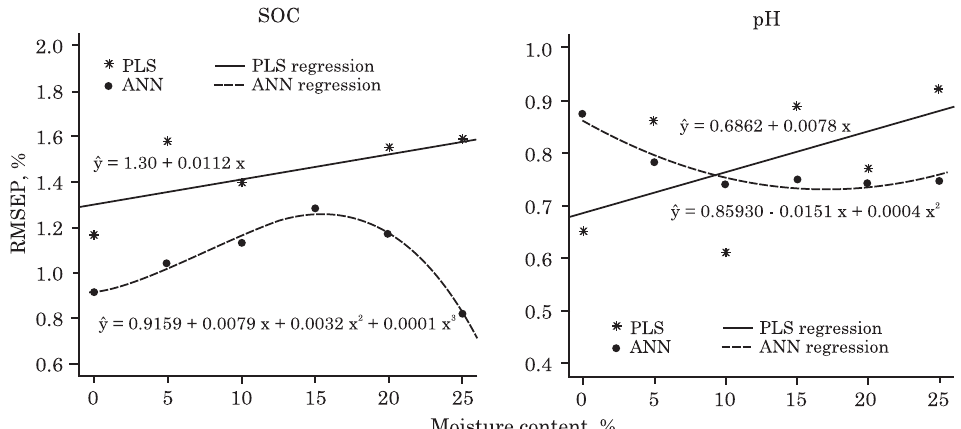
Figure 5. Root mean square error of prediction (RMSEP) for PLS and ANN models at different moisture content (MC) levels.